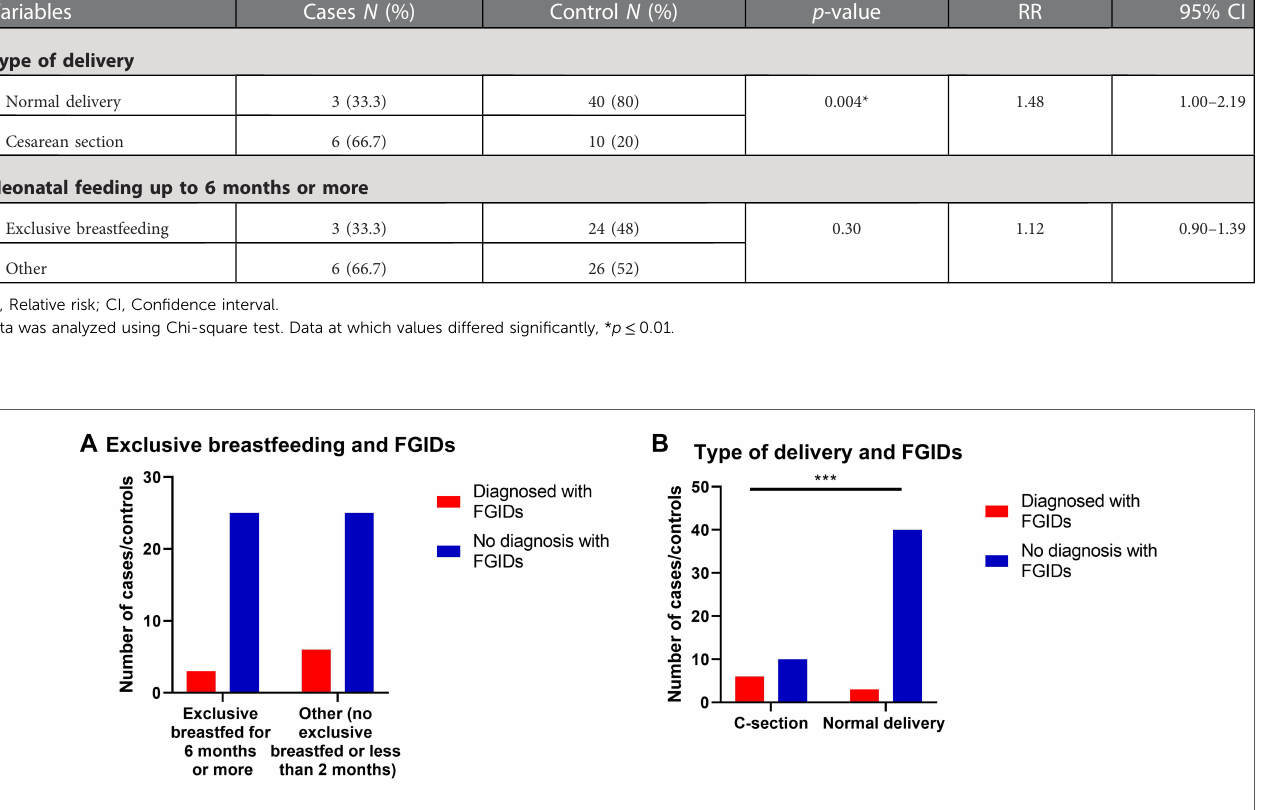
FIGURE 2 The relationship between FGIDs and type of delivery and neonatal feeding. Data represent frequency ( n =59) of ( (cid:129) ) cases and ( (cid:129) ) controls of ( A ) neonatal feeding and FGIDs, ( B ) type of delivery and FGIDs. Chi-square test was used to test the relative risk of type of delivery and neonatal feeding on developing FGIDs. Data at which values differed signi fi cantly, * p ≤ 0.05, ** p ≤ 0.01, *** p ≤